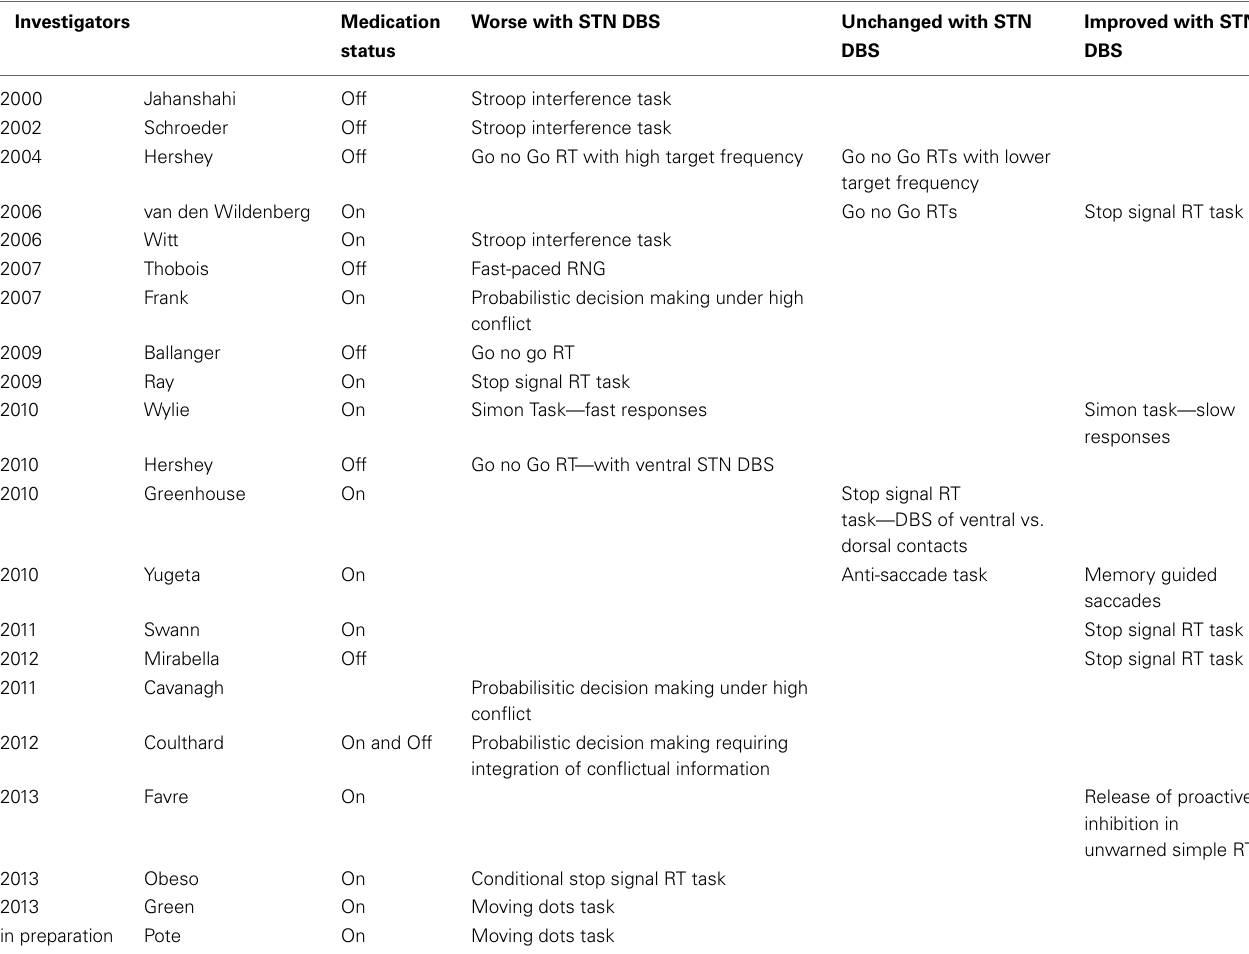
Table 1 | Studies which have investigated the effect of deep brain stimulation (DBS) of the subthalamic nucleus (STN) in Parkinson’s disease on tasks involving inhibition of prepotent responses, response selection under conflict or decision-making under